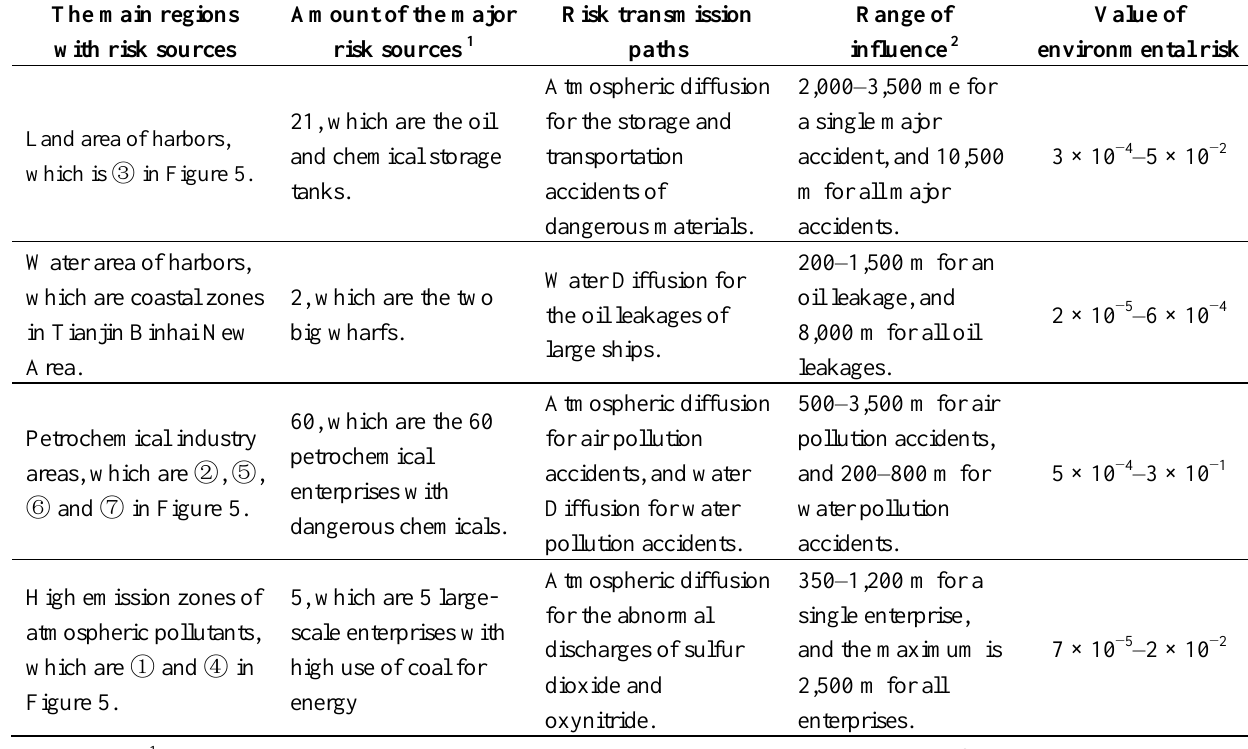
Table 3. The results of risk calculation of typical environment pollution accidents in Tianjin Binhai New